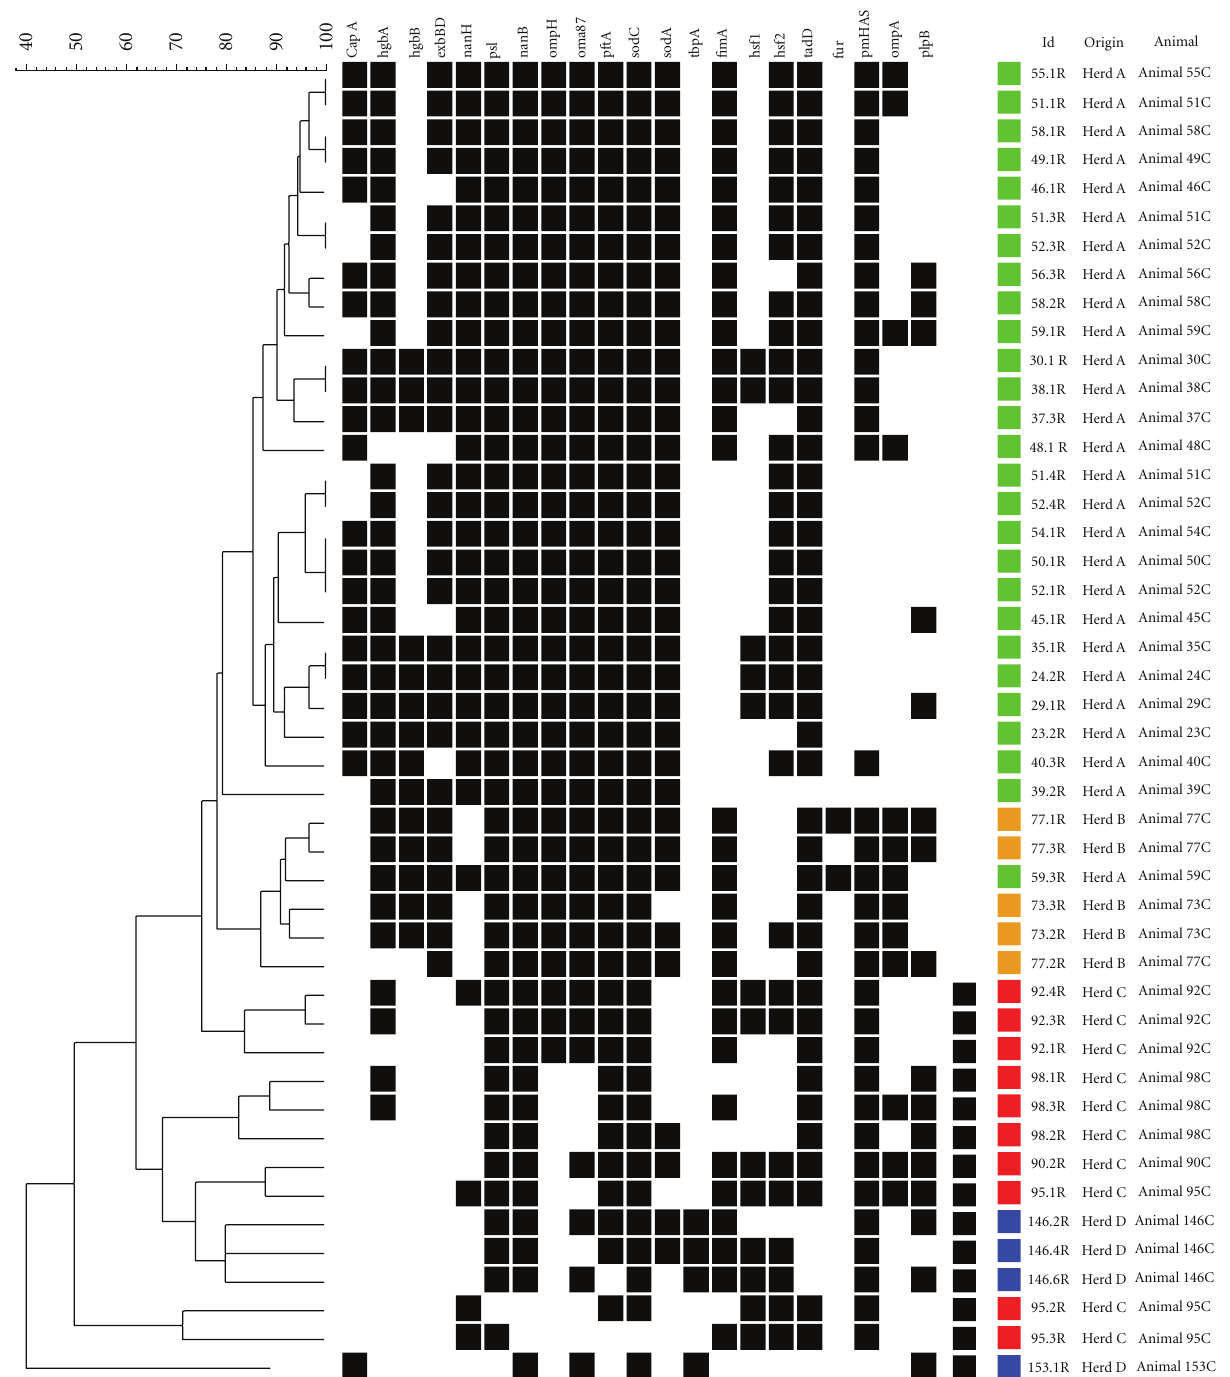
Figure 1: Dendrogram representing relatedness among P. multocida strains isolated from rabbits according to virulence